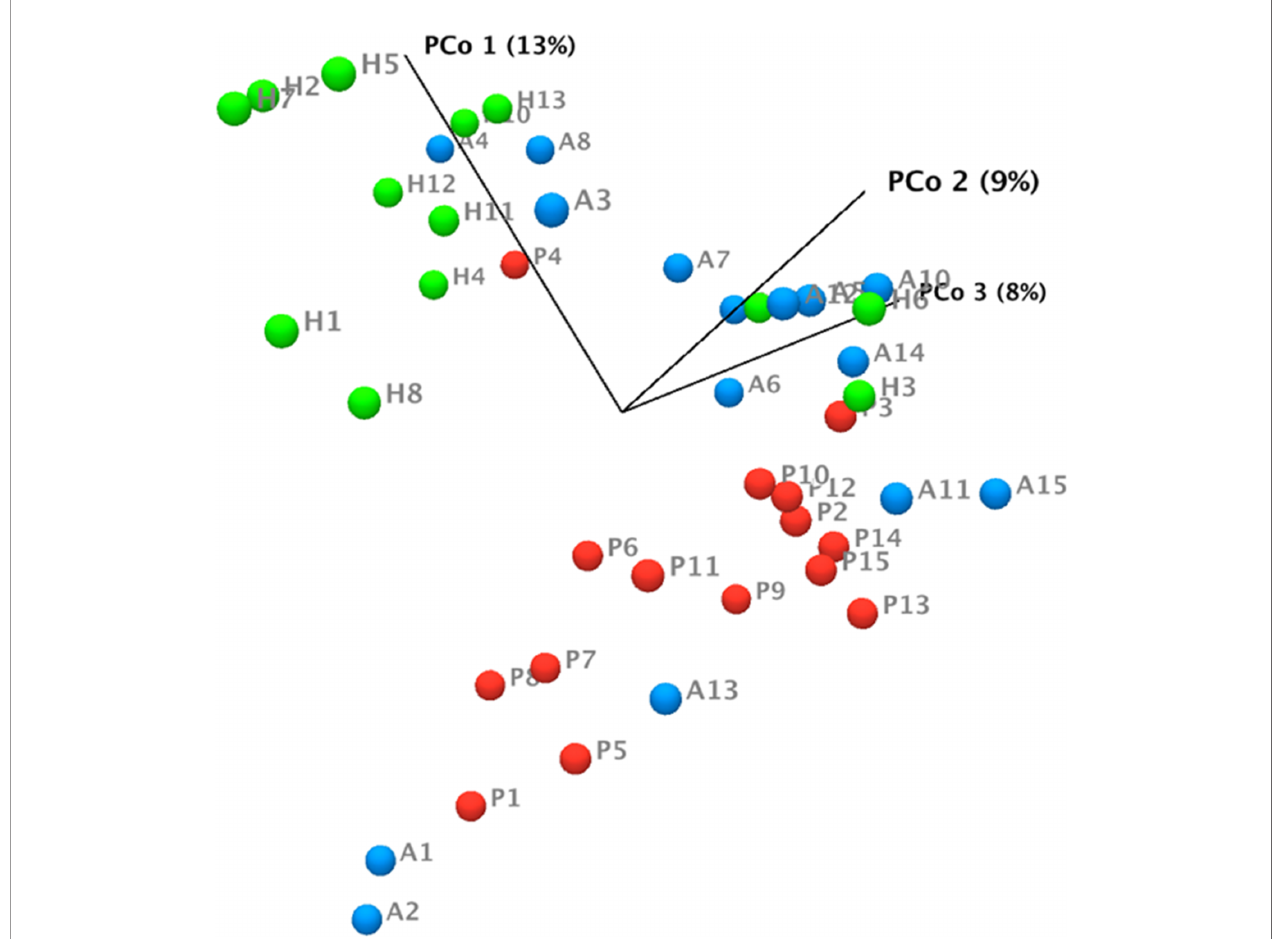
FIGURE 1 | Bray-Curtis principal coordinate analysis (PCoA) plot for subgingival microbiome pro fi les. Axis one accounts for 13% of sample variance, while axis two and three account for 9% and 8% of variance, respectively. One dot represents one sample in each group. This plot demonstrates clusters of samples based on their similarity of microbial composition. These three groups display distinct microbial compositions. (H (green): healthy; P (red): periodontitis before non-surgical therapy; A (blue): periodontitis after non-surgical therapy).